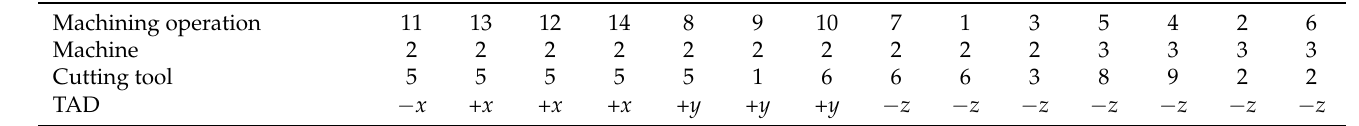
Table 11. Optimal process plans for prismatic part 3 for two conditions.